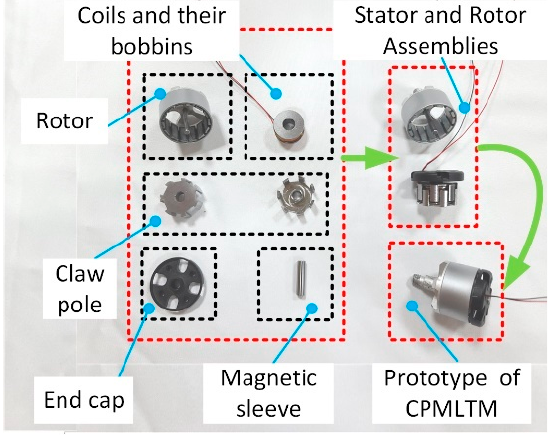
Figure 17. Prototype of